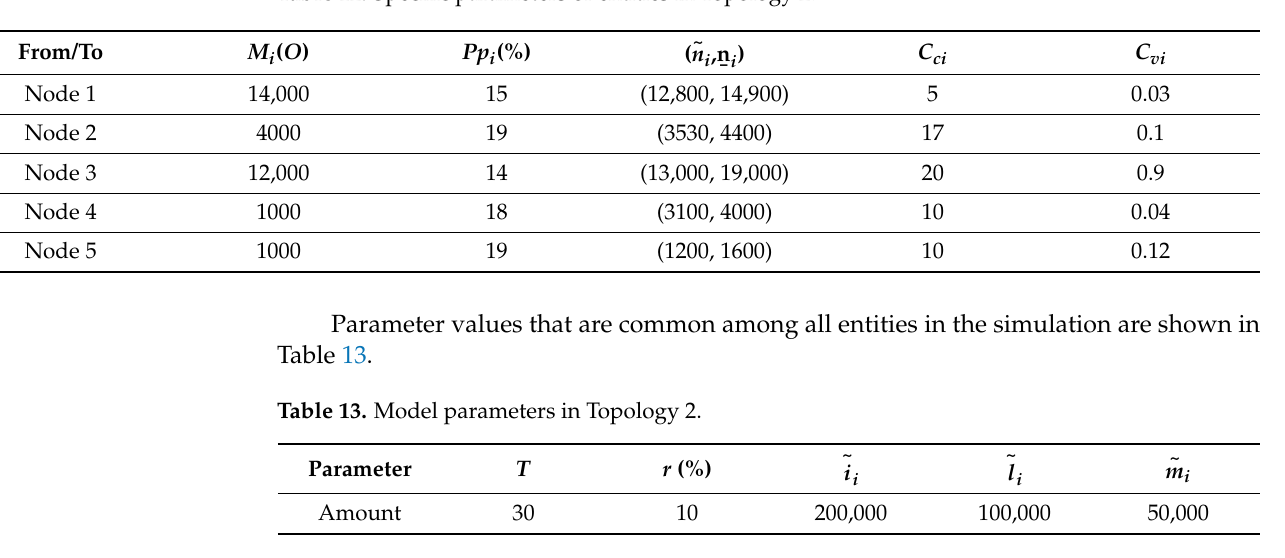
Table 12. Specific parameters of entities in Topology 2.